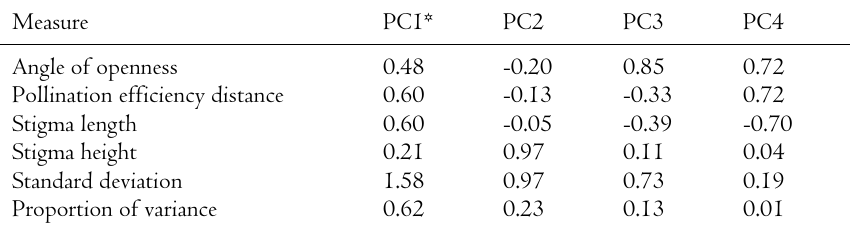
T ABLE 2. Principal components analysis of floral morphology loading scores, standard deviation, and proportion of variance explained for each measured floral trait.